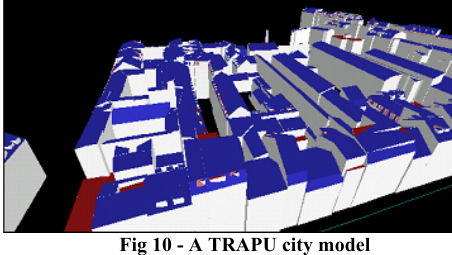
Fig 10 - A TRAPU city